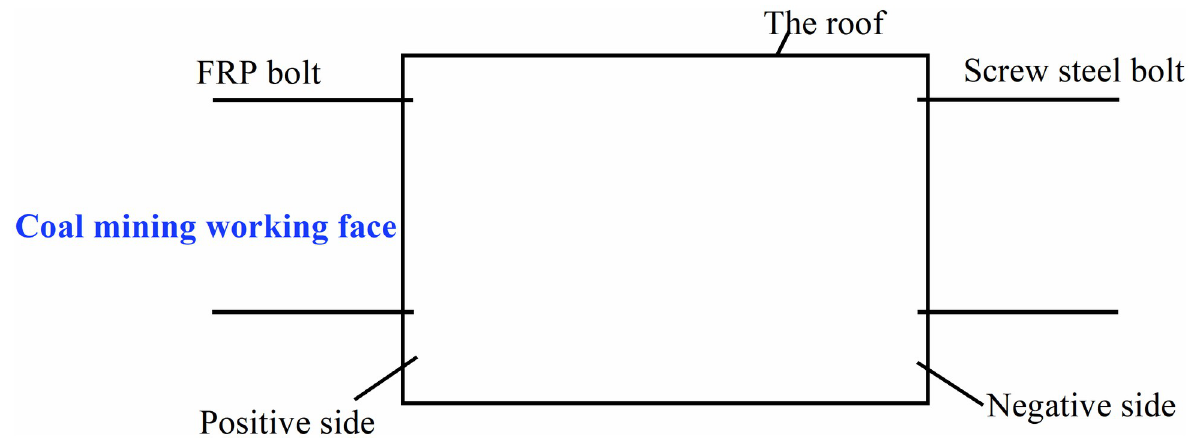
Fig 15. The positive and negative sides.